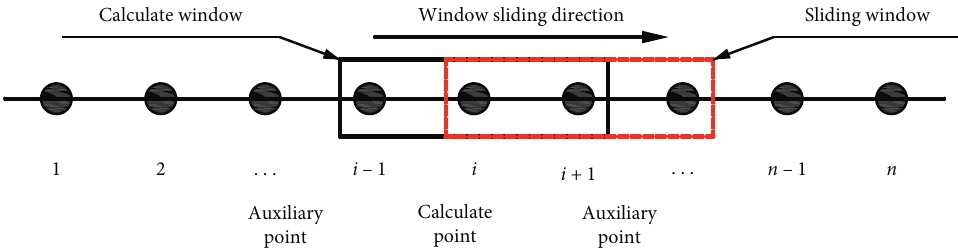
Figure 3: Description of local probability calculation.